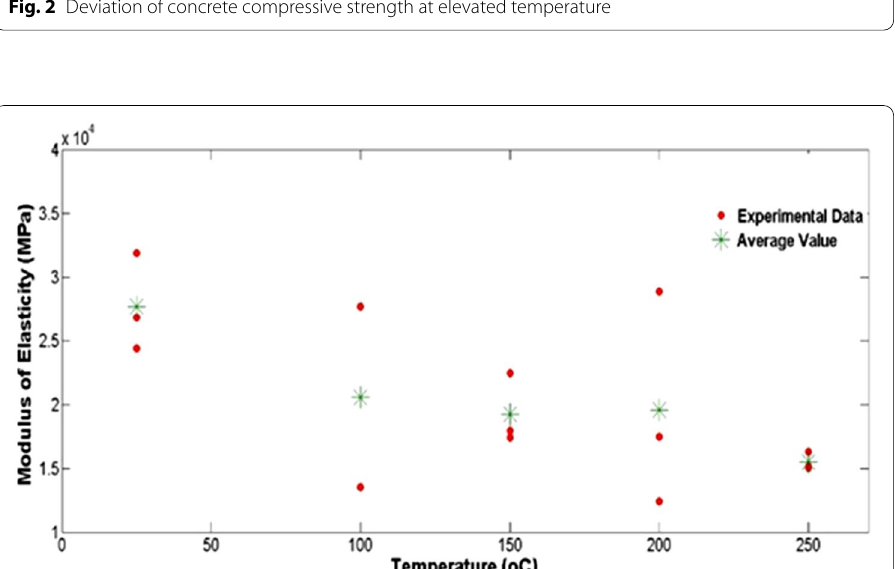
Fig. 3 The concrete modulus of elasticity at various